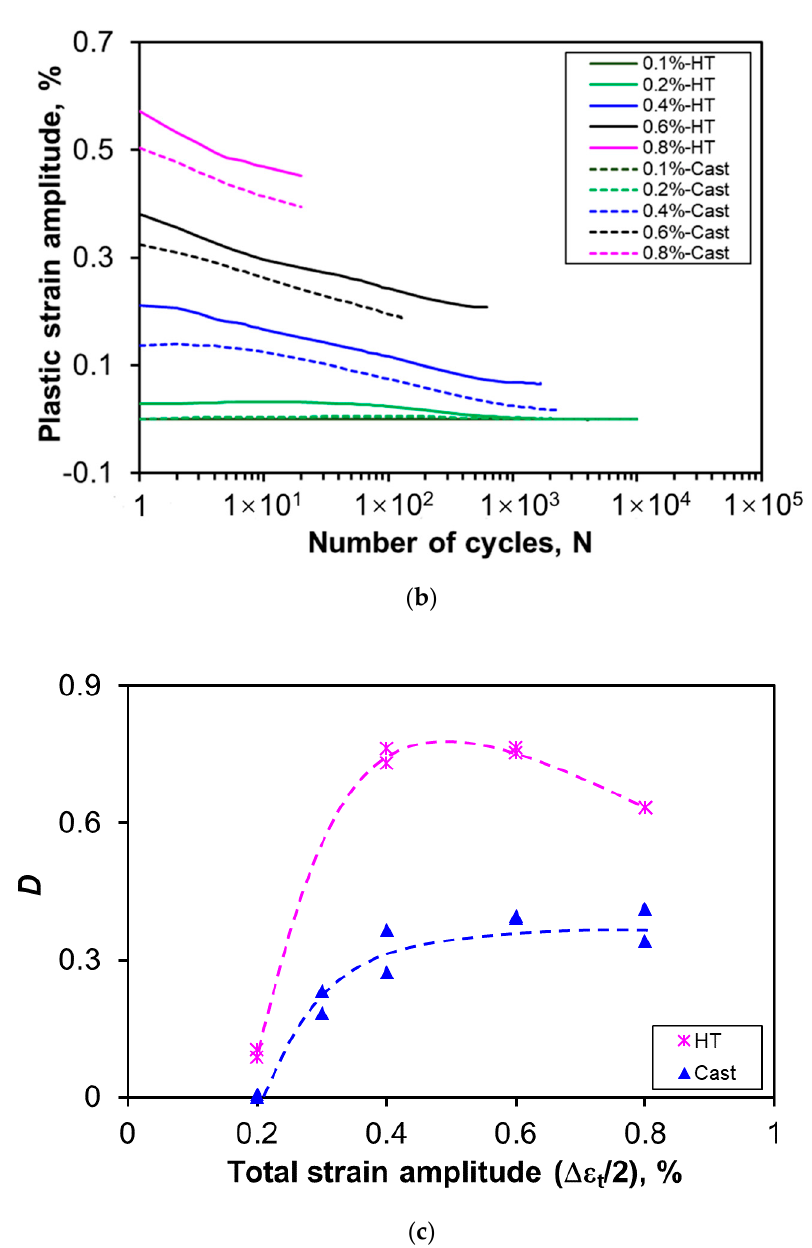
Figure 9. ( a ) Cyclic stress amplitude and ( b ) plastic strain amplitude as a function of number of cycles, and ( c ) newly-defined degree of cyclic hardening ( D ) versus the total strain amplitude in both as-cast and heat-treated alloys tested at a strain ratio of R ε = − 1.